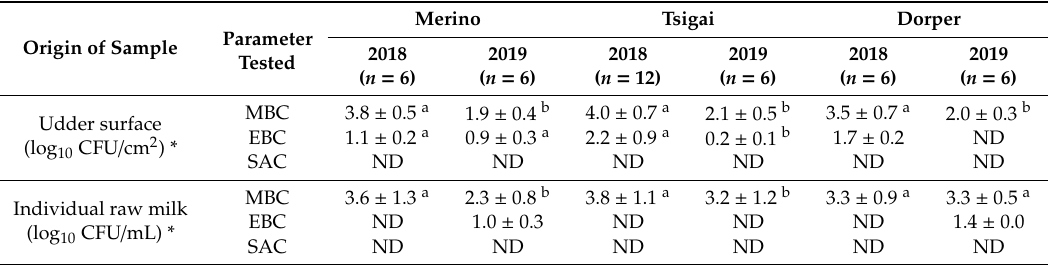
Table 7. Bacteriological quality of udder surface and individual raw milk samples on farm F1 according to breed of sheep and year of